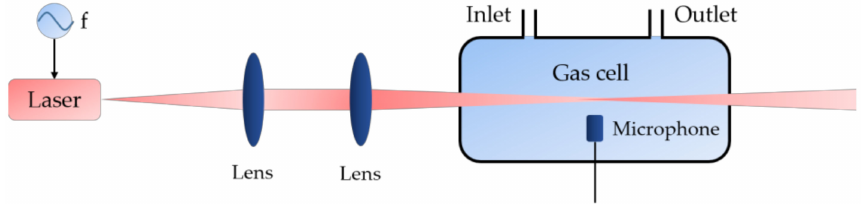
Figure 4. Principle of gas detection based on the photoacoustic spectroscopy. f: periodic modulation with a frequency f